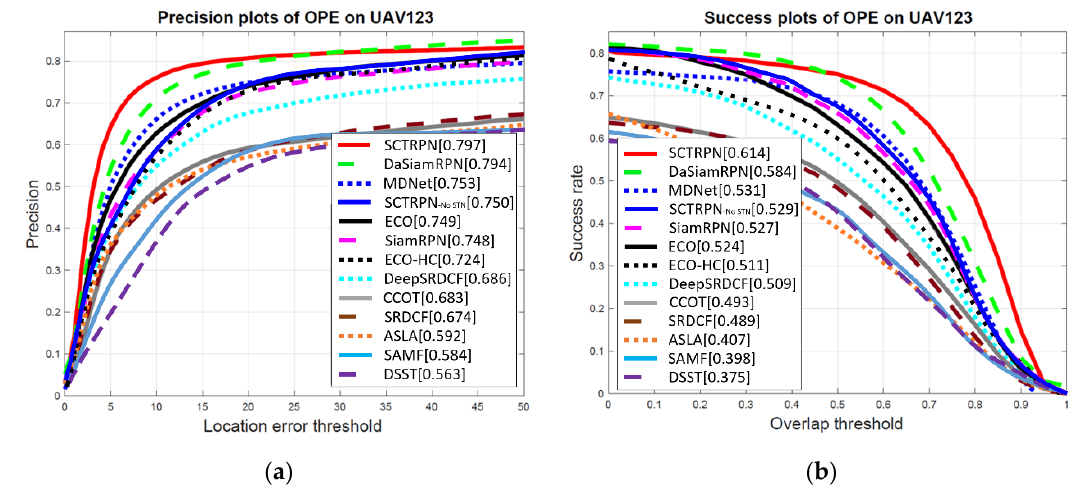
Figure 9. Normalized precision and success plots show a comparison of our SCTRPN tracker with state-of-the-art trackers on the LaSOT dataset. ( a ) Normalized Precision plots of OPE on LaSOT Testing Set; ( b ) success plots of OPE on the LaSOT Testing Set.